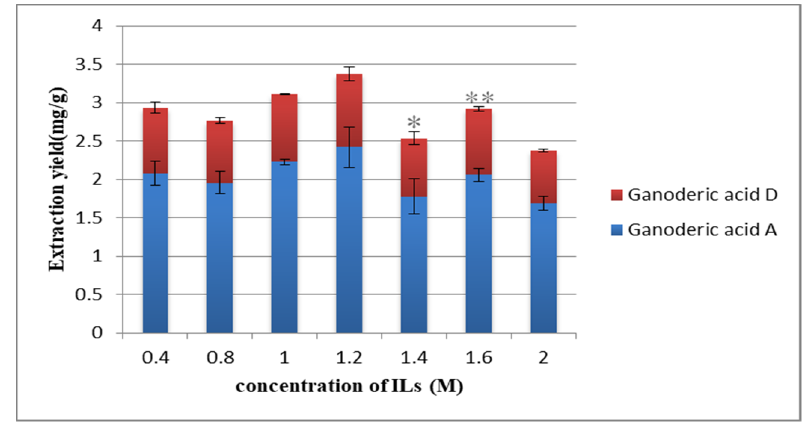
Figure 4. Effect of concentration of ionic liquids (ILs) on the extraction yield. Compared with 1.2M group: ** p < 0.01; * p < 0.05.